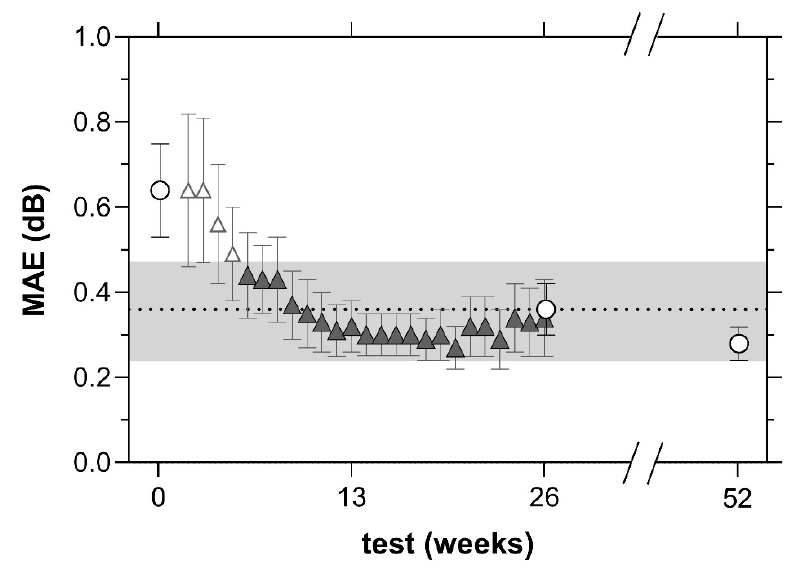
Figure 5. Mean absolute error (MAE, dB) from the median retinal sensitivity calculated from the average of 3 MAIA tests performed in-clinic (circles) and 26 MRFh tests performed at home (triangles) in n = 46 participants with intermediate AMD. The unfilled triangles are shown from week 2 and represent a period of learning where the MAE approaches its plateau. Error bars show SEM. The black dotted line shows the MAE of the MAIA at week 26. Grey zone represents 2x SEM of the 6-month MAIA result.